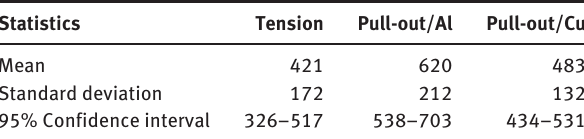
Figure 11 Typical tensile stress-deflection behavior of